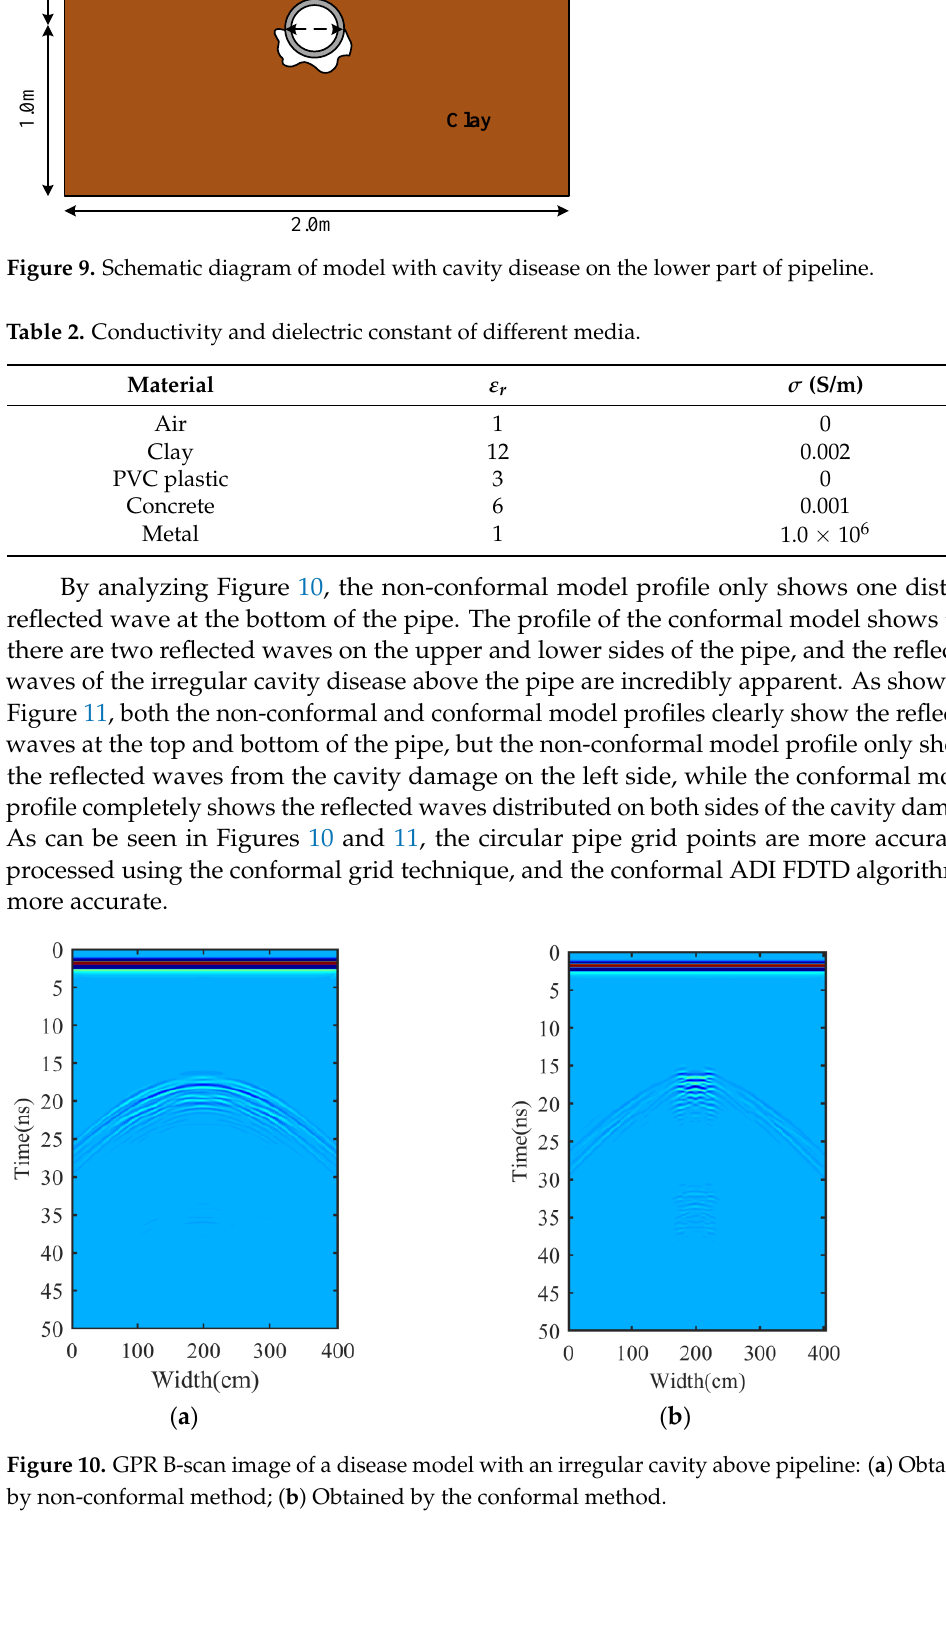
( b ) Figure 11. GPR B-scan image of a disease model with an irregular cavity below pipeline: ( a ) Ob- tained by non-conformal method; ( b ) Obtained by the conformal method. 3.3. Complex Multi-Pipe Model This model used the conformal ADI-FDTD algorithm to simulate the complex multi- tube model. Figures 12 and 13 show the schematic diagrams of complex multi-pipe mod- els. Figure 12 shows an underground concrete multi-pipe model, with pipe diameters of 0.03 m, 0.06 m, and 0.1 m. Figure 13 shows an underground multi-pipe model with pipe diameters of 0.4 m. The pipe materials were concrete, metal, and PVC plastic. The space step and time step were set as 0.005 m and 0.01 ns, and simulation iterations were 5000.